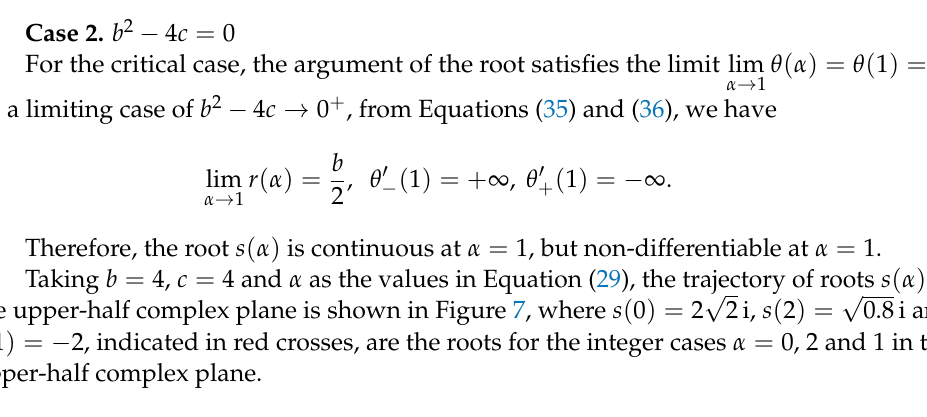
Figure 6. Trajectory of roots s ( α ) for α varying between 0 and 2, where b = 4 and c = 3 ( b 2 − 4 c > 0 )